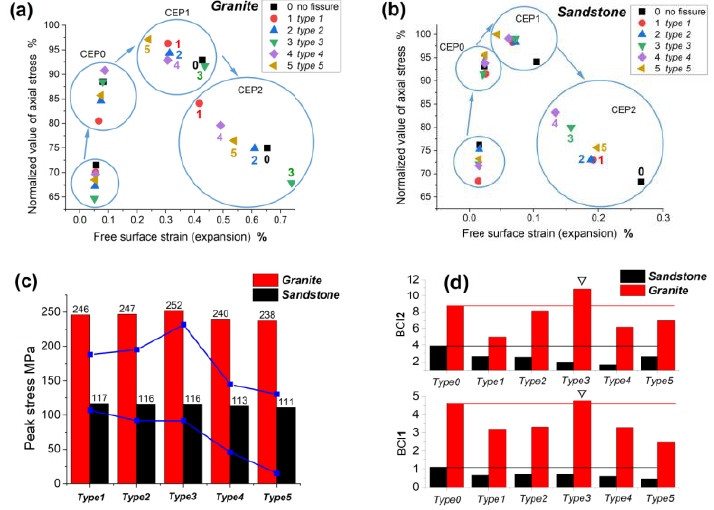
Figure 8. Characteristic points and